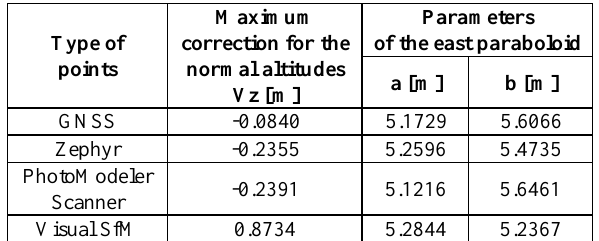
Table 7. The residuals of the 3D models characteristic